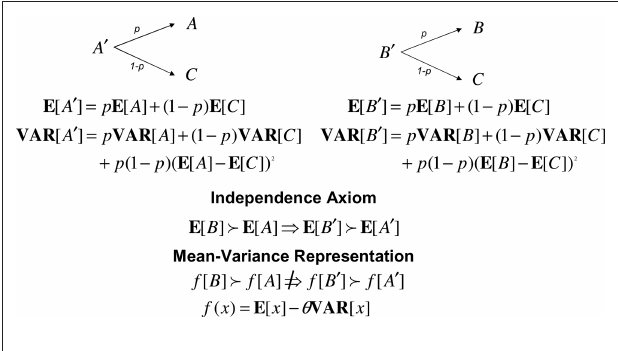
Figure A1 | Violation of independence axiom. If we assume two lotteries A and B with the preference B  A and we create two new composite lotteries A ′ and B ′ by adding a “common consequence” lottery C to both A and B such that lottery A ′ gives again lottery A with probability p and lottery C with probability 1 − p , and lottery B ′ gives lottery B with probability p and lottery C with probability 1 − p , then the independence axiom of expected utility theory requires that we have the preference B ′  A ′ . We can see this immediately by comparing the expectation values of the composite lotteries and by subtracting the expected utility of the common consequence C . However, if we represent our preferences using the mean–variance approach, the preference between A ′ and B ′ also depends on the variance terms arising from the distance to C . The preferences are therefore not independent from the third consequence. For details see (Bar-Shira and Finkelshtain,